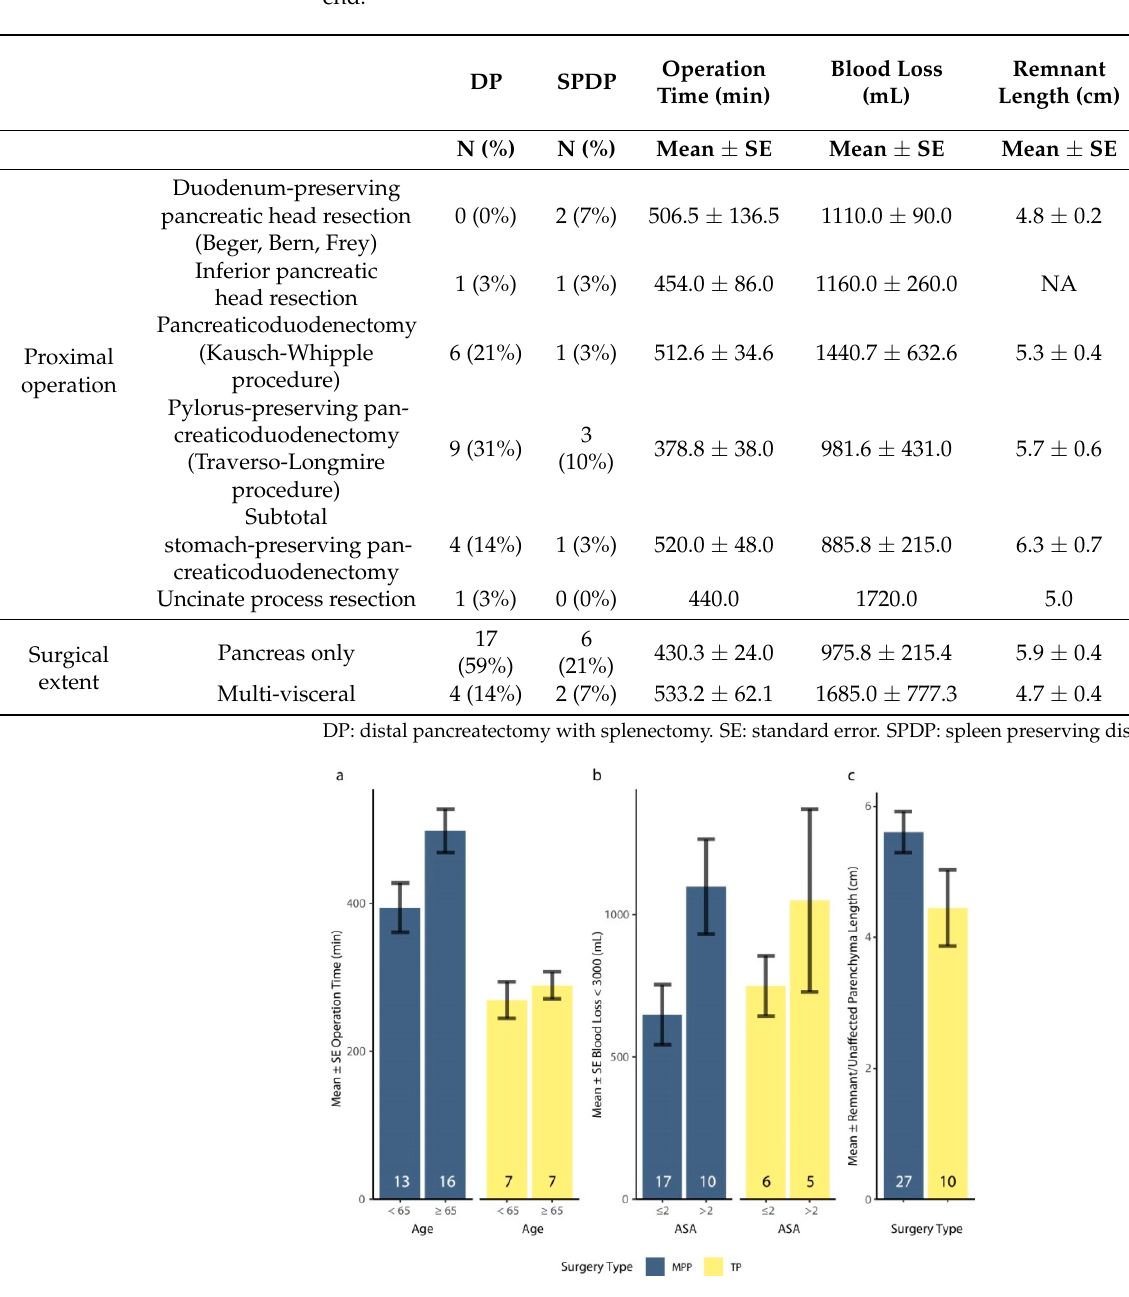
Figure 3. Mean ± SE ( a ) operation time (min) factored by age and surgery type, ( b ) blood loss (mL) factored by ASA classification and surgery type, and ( c ) length of the remnant (MPP) or estimated unaffected parenchyma (TP) by surgery type. The number of cases for each category is provided within the column. ( b ) Excludes 1 missing value and 2 patients with outlying blood loss. ( c ) Excludes 6 missing values for the respective response. ASA: American Society of Anesthesiologists. MPP: middle segment-preserving pancreatectomy. SE: standard error. TP: total pancreatectomy.